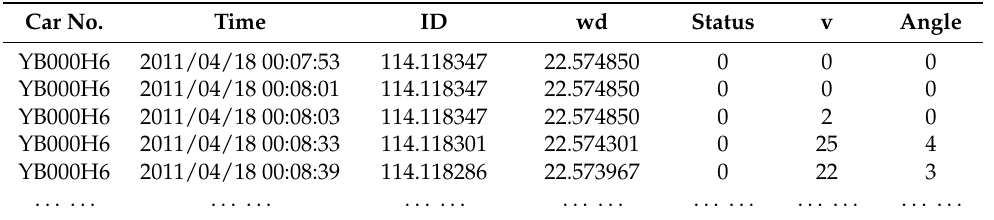
Table 10. Experimental GPS data format (using one vehicle as an example).